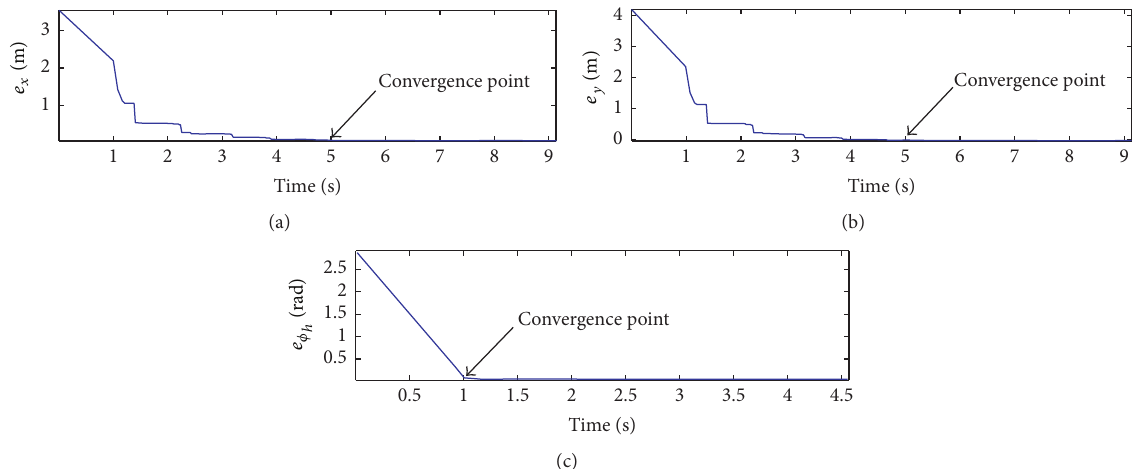
Figure 4: Precision versus time: convergence of the localization system. Blue line depicts the average error of the 20 experiments.